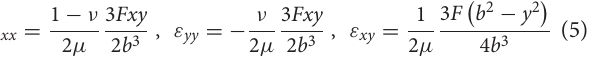
FIGURE 5 | An arbitrary shape fully enclosed with a grid which is refined in close proximity to the boundary of the shape. The blue dots represent the weights of the Lagrange polynomials used for the bilinear interpolation of the boundary values with the coarse